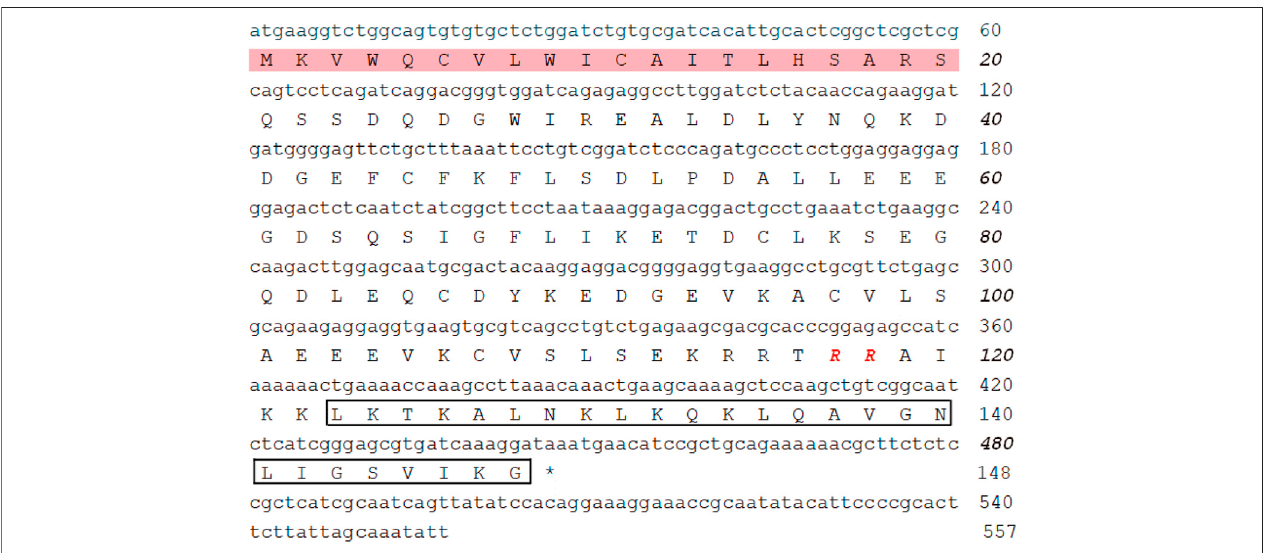
Frontiers in Pharmacology |